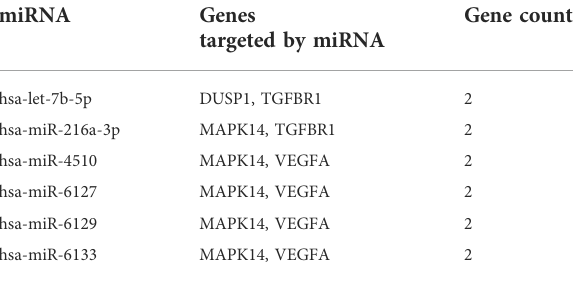
TABLE 2 miRNAs and its target genes.